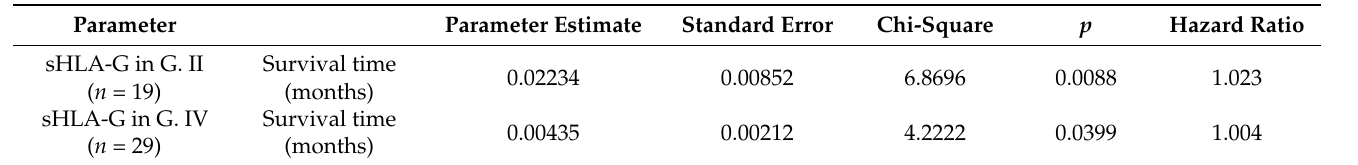
Table 8. Cox proportional hazard analysis of sHLA-G and survival time in grade II and IV glioma patients.